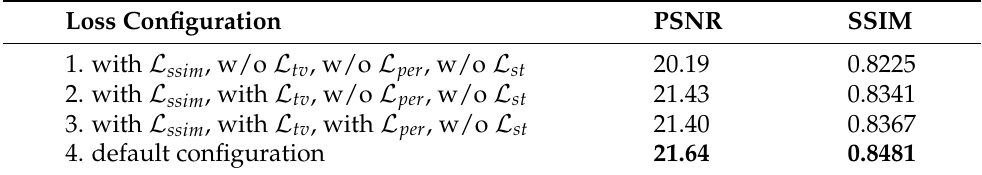
Table 5. Ablation results of loss function on LOL dataset. The best results are in